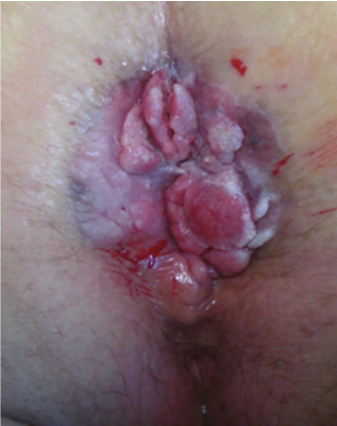
Figure 3: The perineal and perianal areas at 36 months postopera- tively with a satisfactory appearance and no